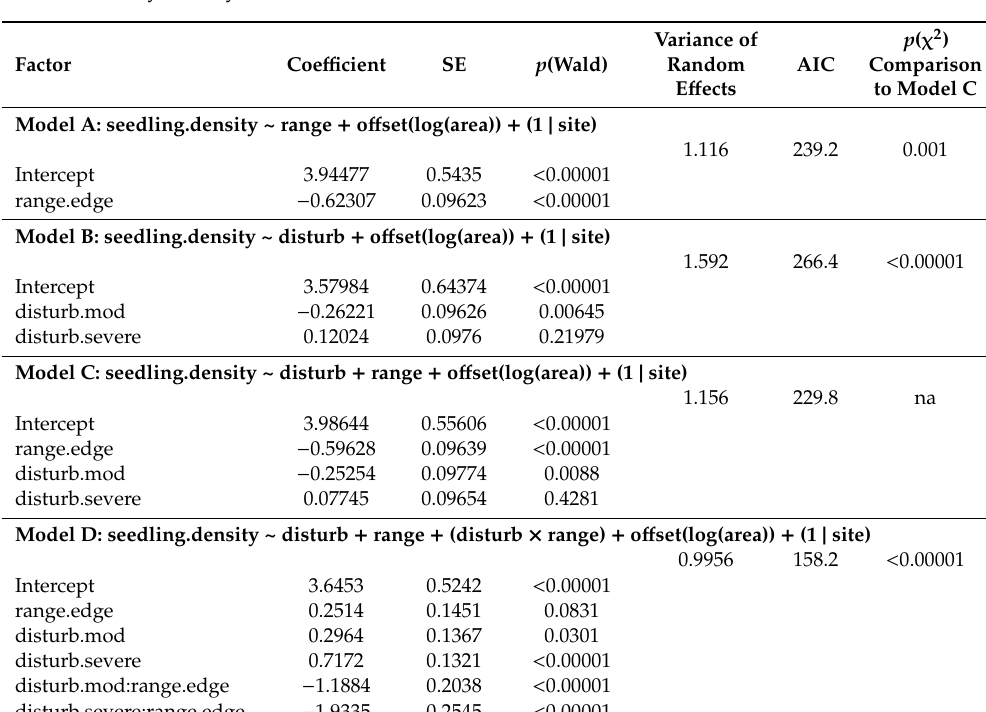
Table 2. Whitebark pine seedling density results for Study #2 generalized linear mixed models (GLMM). Explanatory variables (disturbance and range position) are factors. Those with multiple levels are assigned codes representing predicted values from each baseline category, where intercepts represent the first category. Estimated coe ffi cients, standard errors (SE), and p -values for Wald tests are shown for each variable. Akaike Information Criteria (AIC) are given, plus log-likelihood ratio test results comparing Models A, B, and D to Model C to isolate the significance of each variable, using chi square ( χ 2 ) as a test statistic. Disturb = disturbance level; range = range position; area = survey area size; and site = study